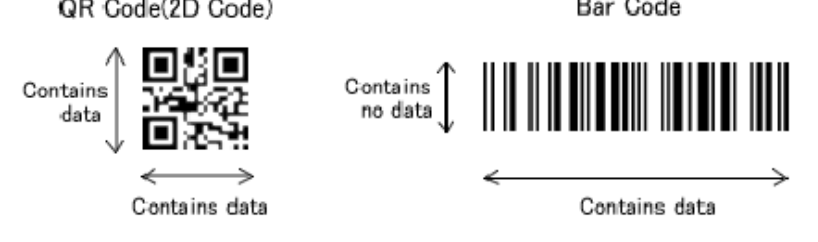
Fig. 1. Comparison of QR code and Bar